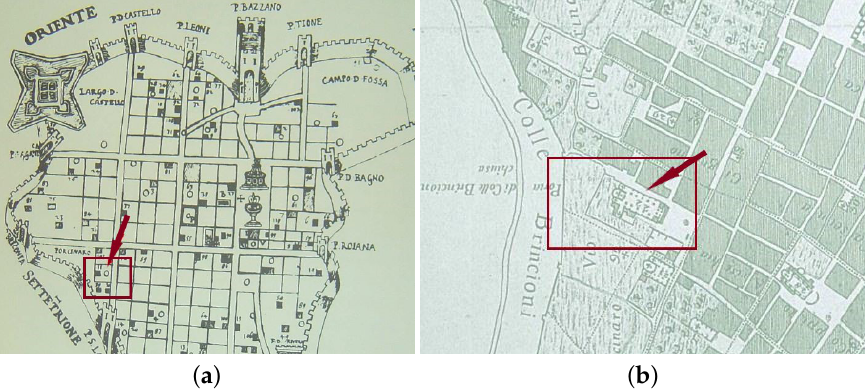
Figure 5. ( a ) Historical Maps by Fonticulano, 1575 and by Vandi, 1753 ( b ). Currently, the building exhibits the main features of medieval architecture. The church has a 60.23 m by 22.54 m rectangular plan, Figure 6. The interior consists of three naves: the length of the central nave is two times the length of the lateral ones. Two masonry walls, 0.80 m thick and 5 m high, with six and seven ogival arches respectively, divide the naves between each other. The facade is in Gothic style, with a central rose window, Figure 2b. The belfry stands by the right side of the façade. It has a 5.5 m by 6.9 m rectangular plan and is 33 m high. A steel staircase reaches the bell cell, see Figure 7, distinguished by slender masonry piers and large